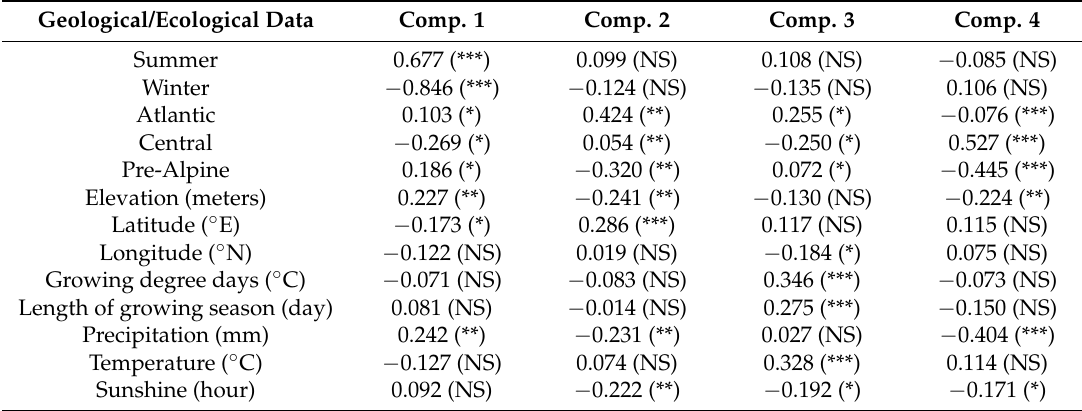
Table 6. Correlation of the background data (season, region, climate, geology, and ecology) with the four components of Table 4. Season and region of production based on ANOVA of the expressed factor scores, and others based on Pearson correlation; the level of significance in between